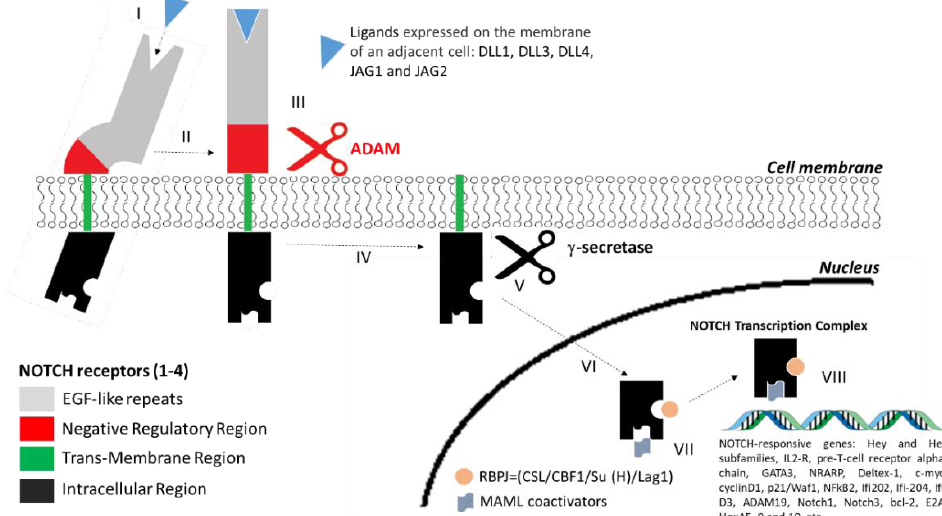
Figure 2. Schematic representation of NOTCH signalling pathway: Sequential steps in the NOTCH signalling pathway are shown as follows: I: NOTCH receptor binding to specific ligands; II: conformational change of the receptor; III: ADAMs-mediated cleavage; IV: recognition of the intracellular region by γ -secretase; V: γ -secretase mediated cleavage; VI: nuclear translocation ; VII: binding to RBPJ and MAML; VIII: transcriptional activation DLL: delta-like ligands; JAG: jagged protein; ADAM: a disintegrin and metalloprotease; RBPJ: recombining binding protein suppressor of hairless; MAML: Mastermind-like co-activators.